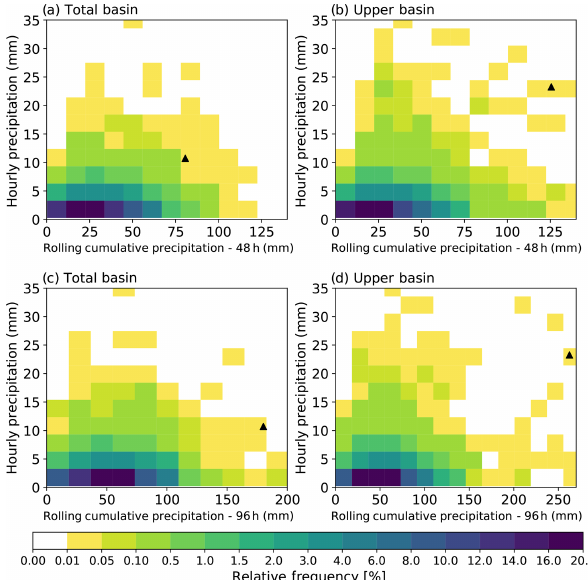
Figure 19. (a, b) Bivariate histogram of the 48h cumulative precip- itation and the hourly cumulative precipitation for the entire basin and for the upper basin, respectively. (c, d) Same as (a, b) for 96h cumulative precipitation. The black triangle corresponds to the La Liboriana flash flood